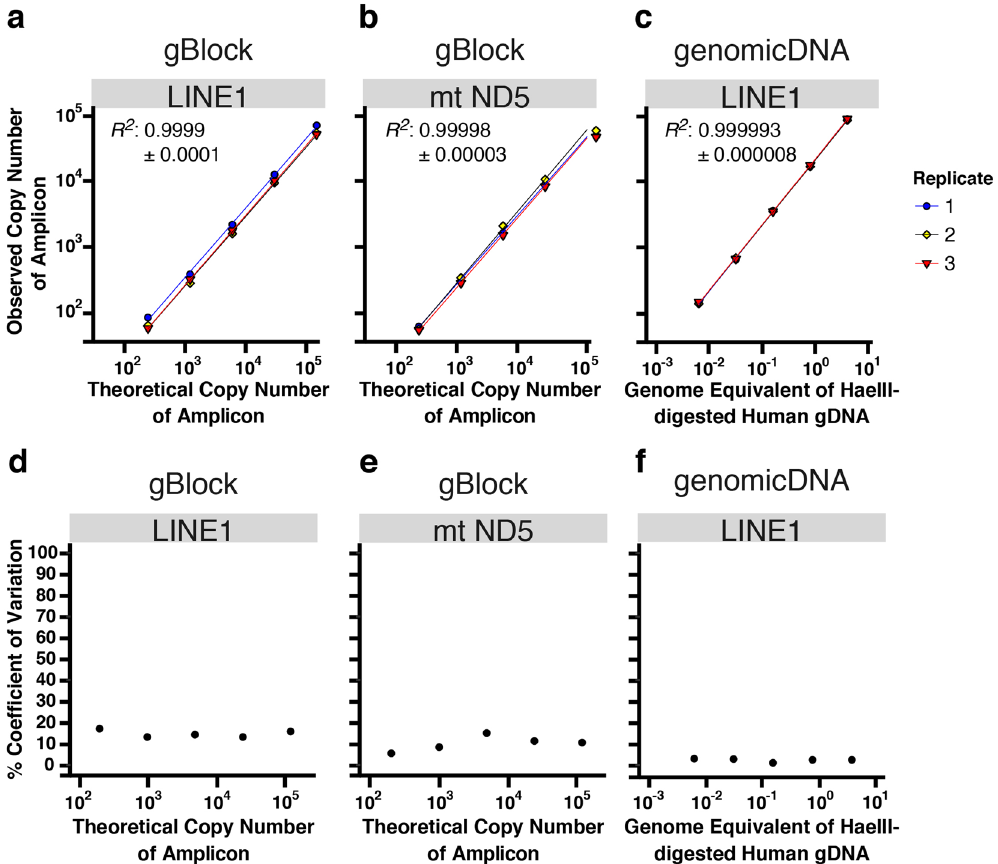
Figure 2. Analytical method validation of the ddPCR assays. Linearity ( a–c ) and reproducibility ( d–f ) of the LINE-1 and mt assays were assessed in triplicate using synthetic gBlocks and digested human gDNA as templates. Data are fitted to linear regression models. Theoretical copy number represents the expected number of molecules based upon the known concentration of the synthetic gBlock solution.